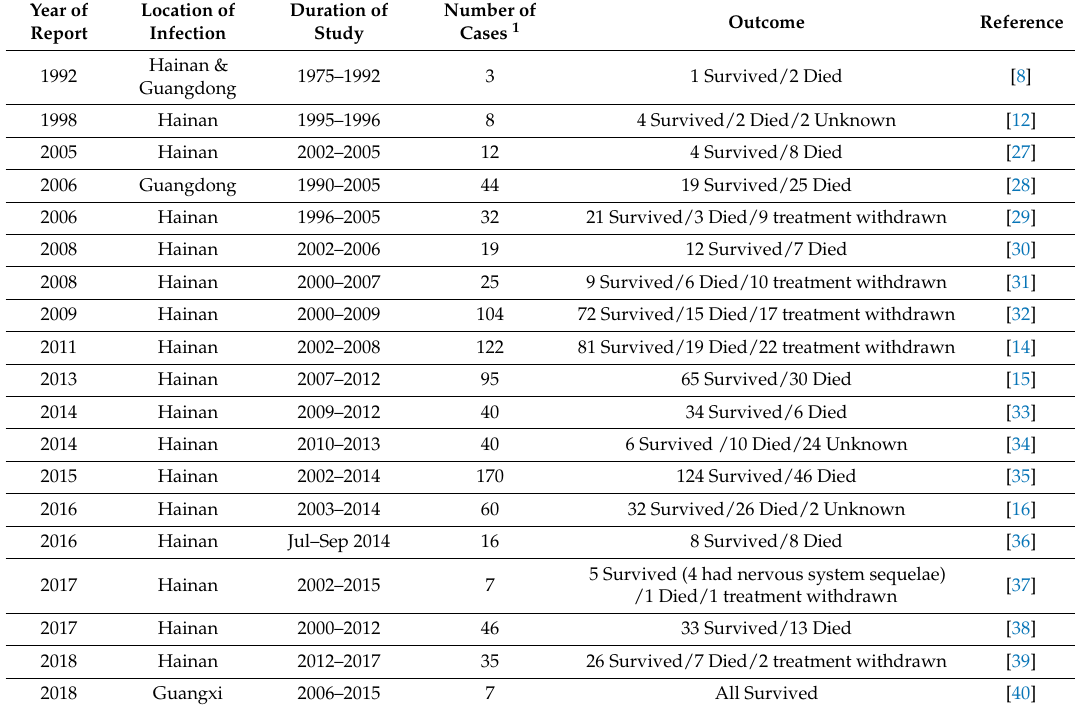
Table 2. Human melioidosis cases reported from Hainan, Guangdong, and